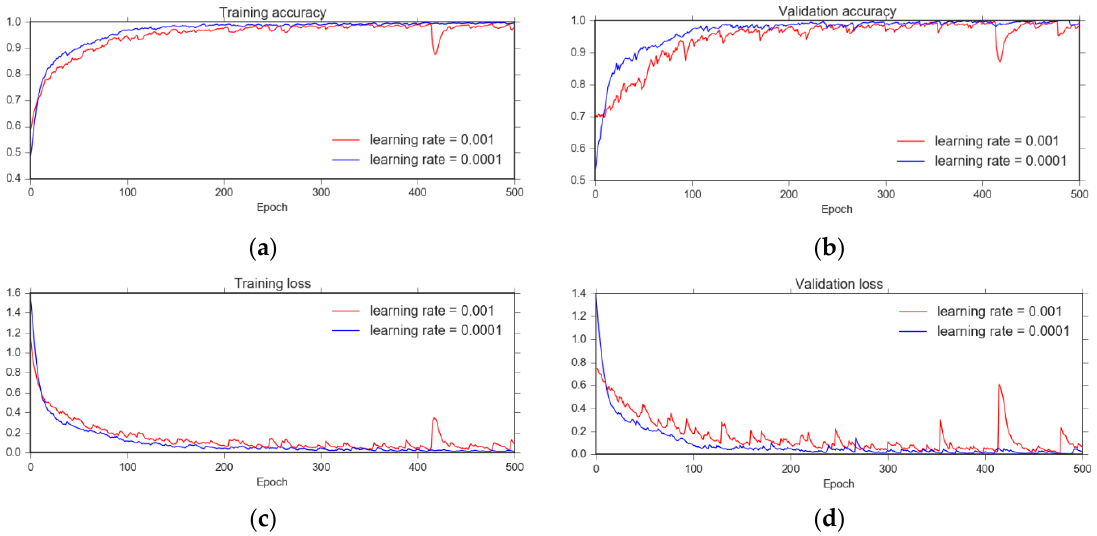
Figure 9. Effect of learning rate: ( a ) Training accuracy plot; ( b ) Validation accuracy plot; ( c ) Training loss plot; ( d ) Validation loss plot.